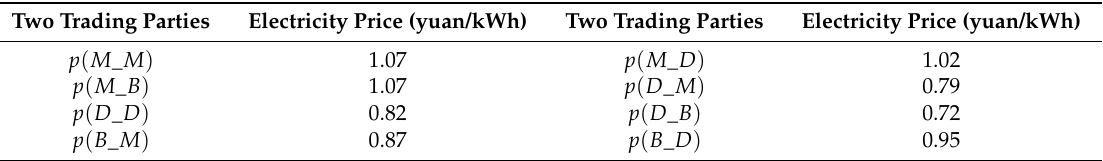
Table 3. Near global optimum bidding strategy at 12:00 p.m.